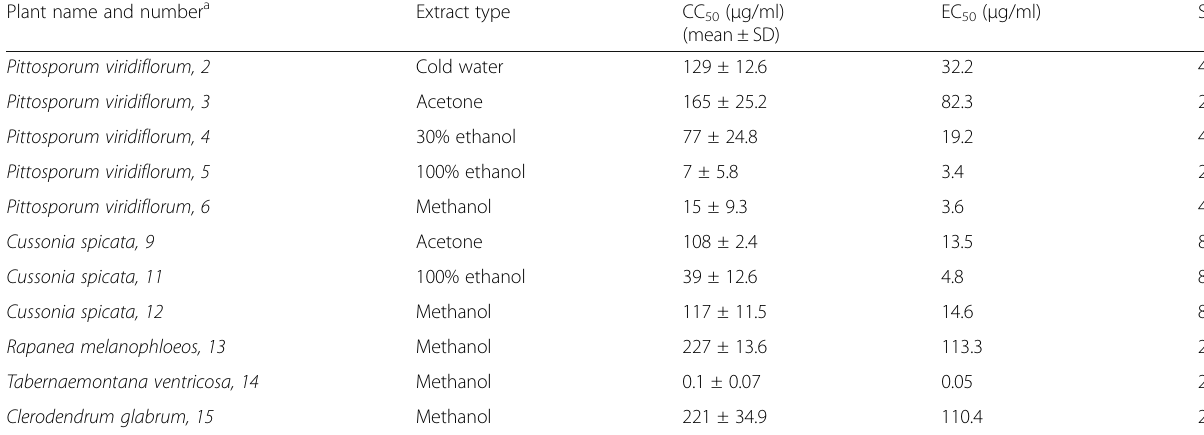
Table 2 CC 50 , EC 50 and SI of the extracts Plant name and number a